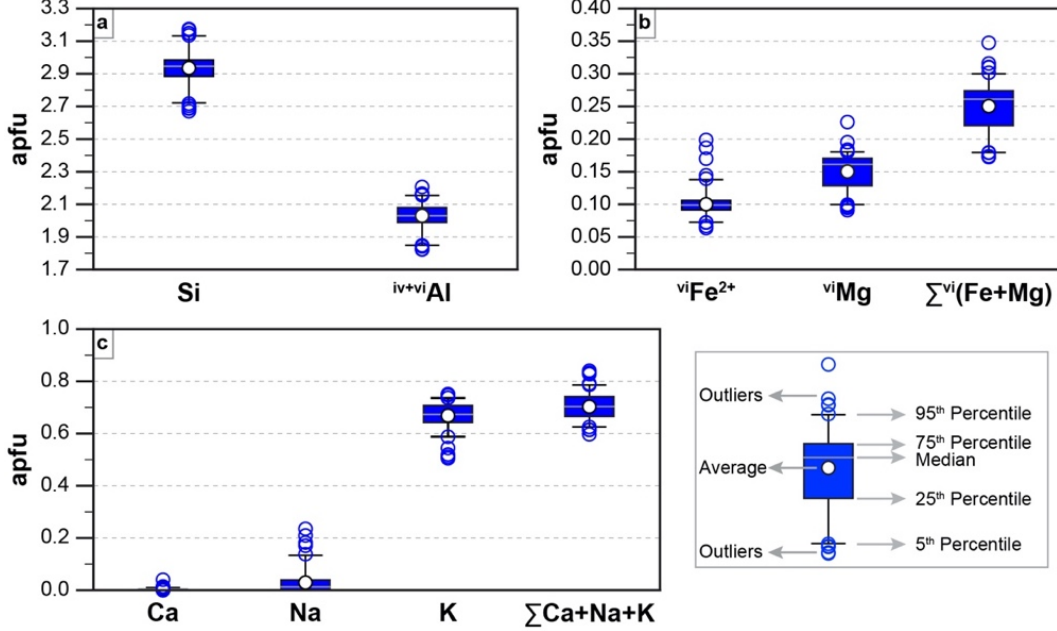
Figure 17. Box-Percentile plots showing range in major and minor elements in apfu within analyzed illite. ( a ) Si and total Al; ( b ) Elements Fe 2+ and Mg 2+ on the octahedral site and their sum; ( c ) Elements Ca, Na, and K on the interlayer site and their sum.